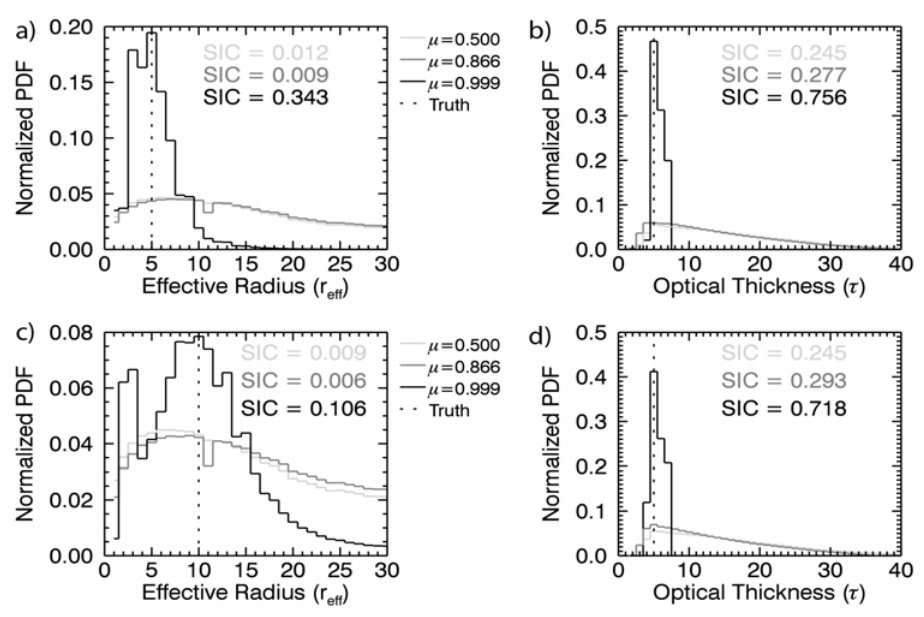
Figure 9. The dependency in the marginal pdfs in cloud optical thickness and droplet = 5, 5 μ m, ( c , d ) τ , r = 5, 10 μ m, effective radius on solar zenith angle for true ( a , b ) τ , r e e = 20, 5 μ m, and ( g , h ) τ , r = 20, 10 μ m. True values in τ and r are indicated with ( e , f ) τ , r e e e vertical dashed lines. Calculations were performed using the slope method for μ = 0.500 0 = 0.866 (dark grey), and μ = 0.999 (black). The normalized Shannon (light grey), μ 0 0 information content in the marginal pdfs with changing μ is indicated on each plot using 0 matching font